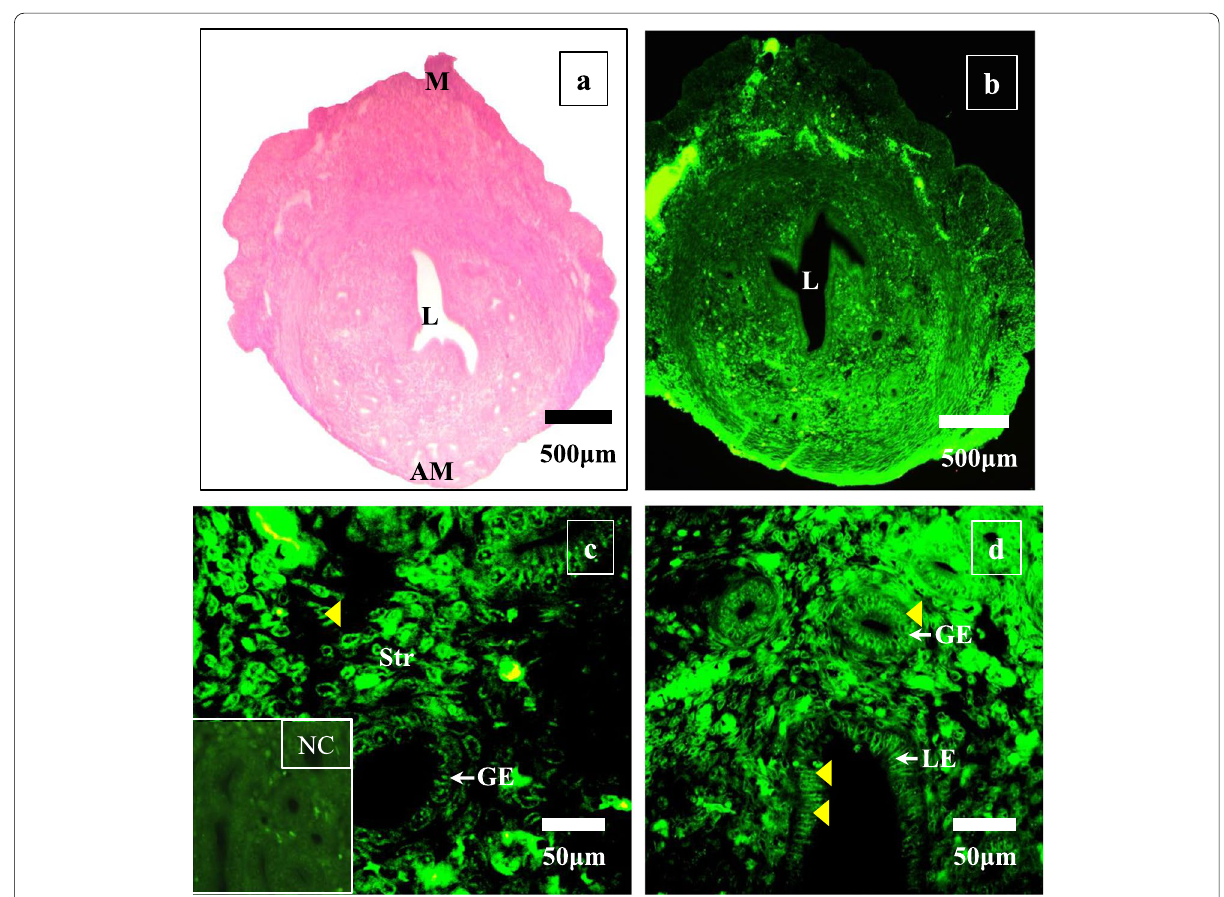
Fig. 10 Immunofluorescence of KLF5 on AntiE2 P4-treated D4 mice uterus using FITC-conjugated antibody. The protein was localized in + the luminal epithelium (LE) and glandular epithelium (GE) of uterine glands and stroma (Str). The arrowhead indicates the expression.